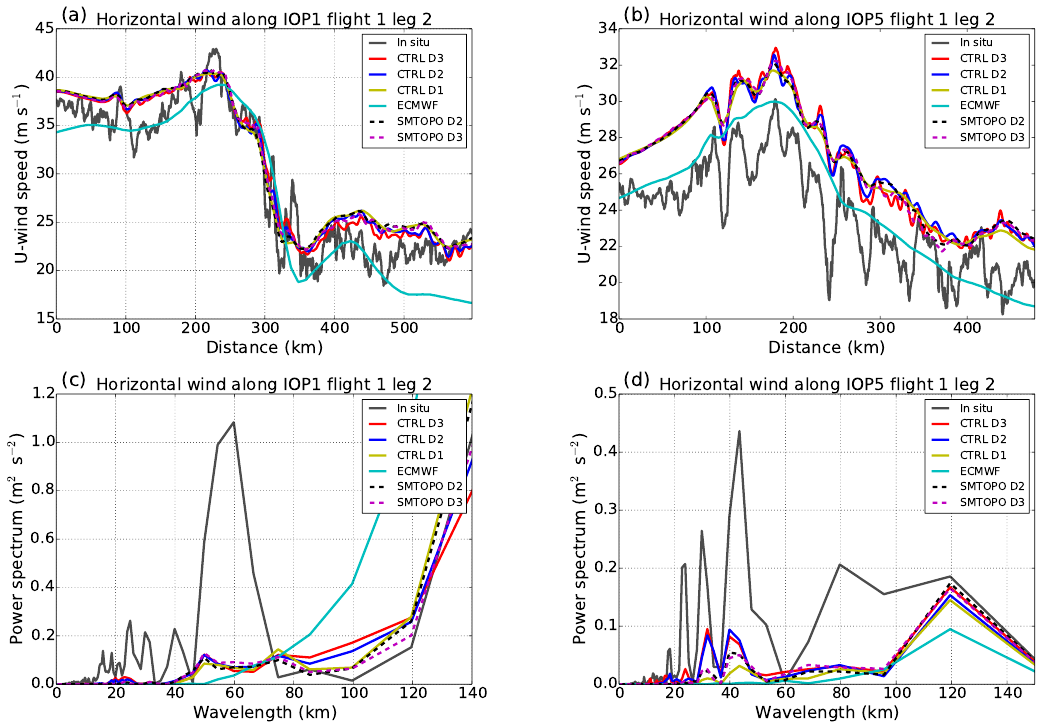
Figure 13. As in Fig. 12, but for horizontal wind from a direction of 300 ◦ at flight